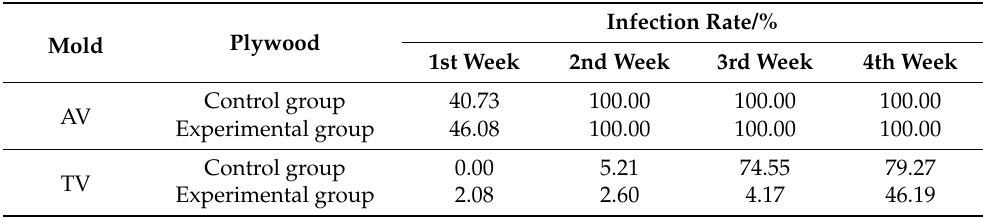
Table 1. Results of anti-mold properties of